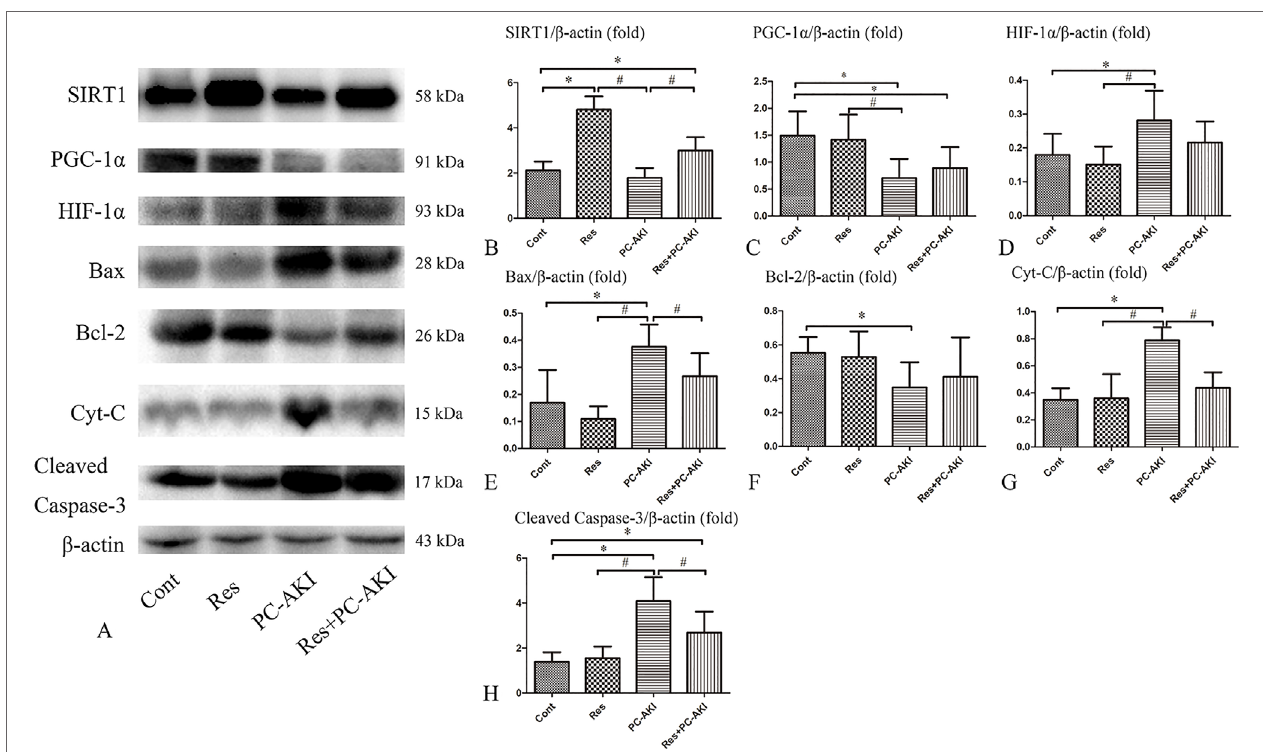
FIGURE 7 | Effects of resveratrol on the expression of SIRT1, PGC-1 α , HIF-1 α and apoptosis proteins in vivo . (A) Activation of the SIRT1–PGC-1 α –HIF-1 α signaling pathway in PC–AKI associated with DN in rabbits. Representative western blot images of proteins in the rabbits with DN treated with saline (Cont), resveratrol alone (Res), iohexol (PC–AKI), and co-treatment with resveratrol and iohexol (Res+PC–AKI). (B – H) Relative densitometry analysis of the ratios of SIRT1–PGC-1 α –HIF-1 α signaling proteins to β -actin were expressed as mean ± standard error. * P < 0.05 vs. Cont; # P < 0.05 vs. PC–AKI. Cont, control; Res, resveratrol; PC–AKI, post- contrast acute kidney injury; SIRT1, silent information regulator l; HIF-1 α , hypoxia-inducible transcription factor-1 α ; DN, diabetic nephropathy; PGC-1 α , peroxisome proliferator-activated receptor gamma coactivator-1